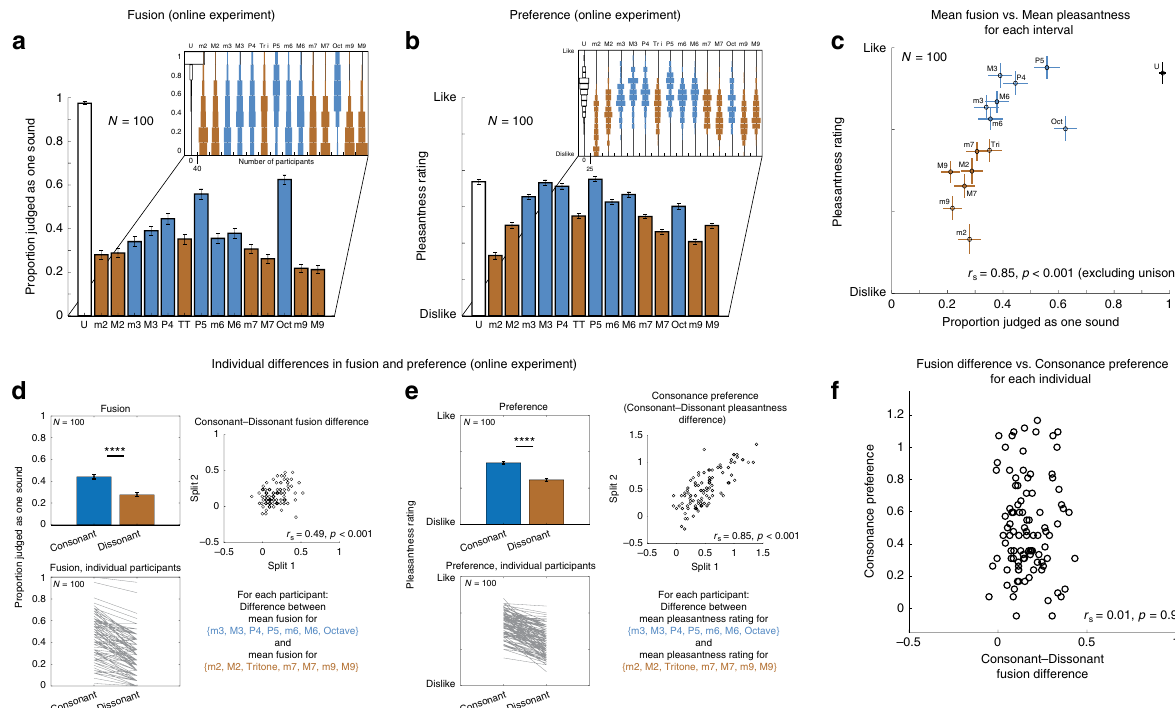
Fig. 4 Results of online fusion and preference experiments in Western participants. a Mean fusion of musical intervals. Here and in ( b ), bars plot mean across participants, error bars plot SEM, and insets show histograms of average responses for individual participants (same conventions as in Fig. 3). b Mean rated pleasantness of musical intervals. c Mean fusion vs. mean pleasantness for individual musical intervals (scatter plot of quantities plotted in ( a ) and ( b )). Error bars plot 95% con fi dence intervals around the mean. r s value is the correlation between the mean fusion and mean pleasantness across intervals. Unison was omitted from correlation as it does not consist of two notes. d Individual differences in fusion. Left panels: mean fusion ± SEM for consonant and dissonant intervals, averaged across all participants (top) or for individual participants (bottom). Consonant and dissonant intervals were all those colored blue and brown, respectively, in ( a ) – ( c ). A Wilcoxon signed-rank test was used to compare the two conditions, **** p < 0.0001. Right panel: test – retest reliability of the difference in fusion for consonant and dissonant intervals, computed from two splits of each participant ’ s trials. Here and in ( e ), reliabilities were Spearman – Brown corrected to best estimate reliabilities of measures derived from full experiment. e Individual differences in consonance preferences. Left panels: mean pleasantness ± SEM for consonant and dissonant intervals, averaged across all participants (top) or for individual participants (bottom). A two-tailed paired t -test was used to compare the two conditions, **** p < 0.0001. Right panel: test – retest reliability of the difference in pleasantness for consonant and dissonant intervals (their “ consonance preference ” ), computed from two splits of each participant ’ s trials. f Consonance preference vs. consonant – dissonant fusion difference for individual participants. Each dot represents a participant. Here and in scatter plots in ( d ) and ( e ), the x -coordinates of individual dots were jittered by a small amount (randomly drawn from U [ − 0.01, + 0.01]) to mitigate the visual effect of dot